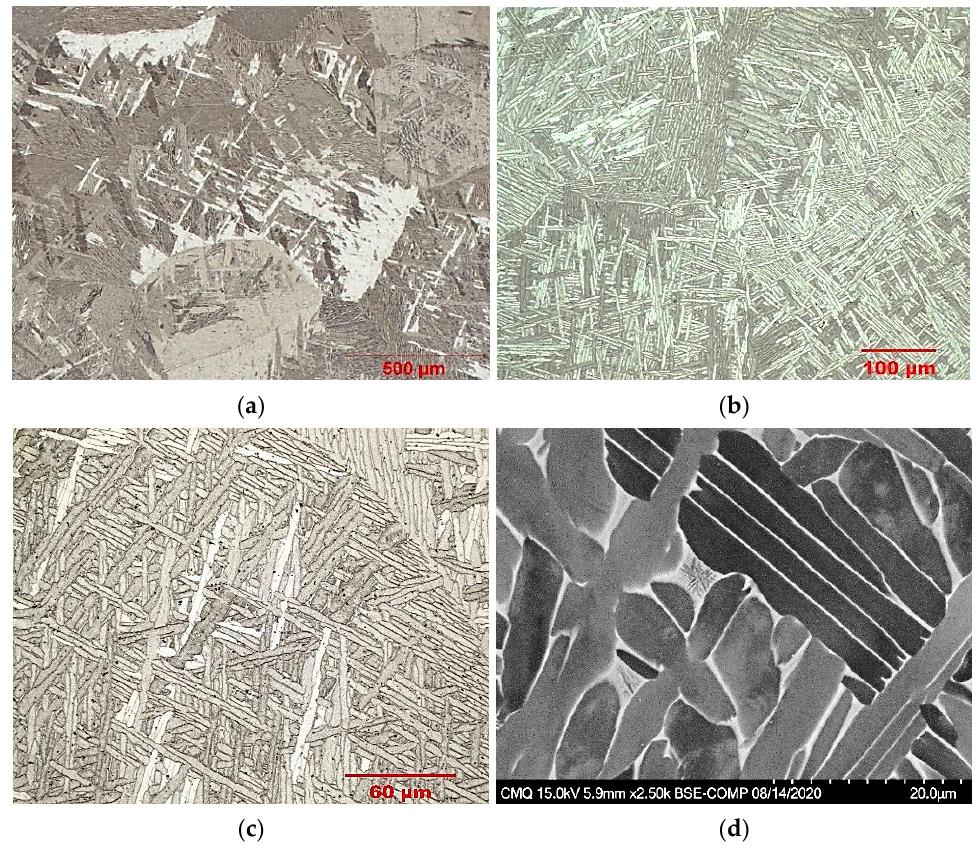
Figure 5. Ti-6Al-4V DPF optical micrographs after annealing and furnace cooled. Representation of the average grain size ( a ). Higher magnification showing the lamellar microstructure ( b , c ). Backscattered electron micrograph showing the alpha lamella morphology ( d ).